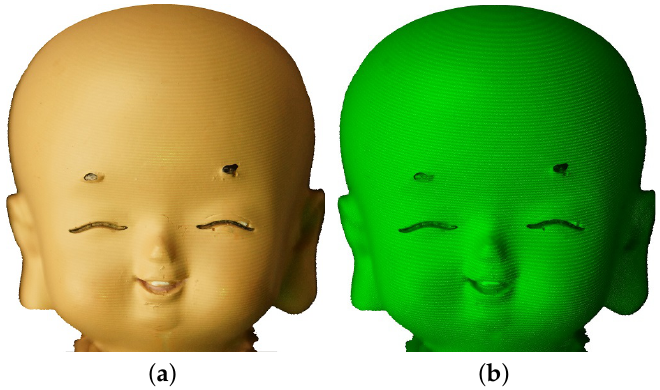
Figure 2. The measuring result of using filtering technique. The target of human head model is illuminated by monochromatic sinusoidal fringe pattern at 532 nm and the background illuminance is E = 3365 Lux : ( a ) image without filtering; and ( b ) image with an optical bandpass filter centered at 532 nm with FWHM being 10